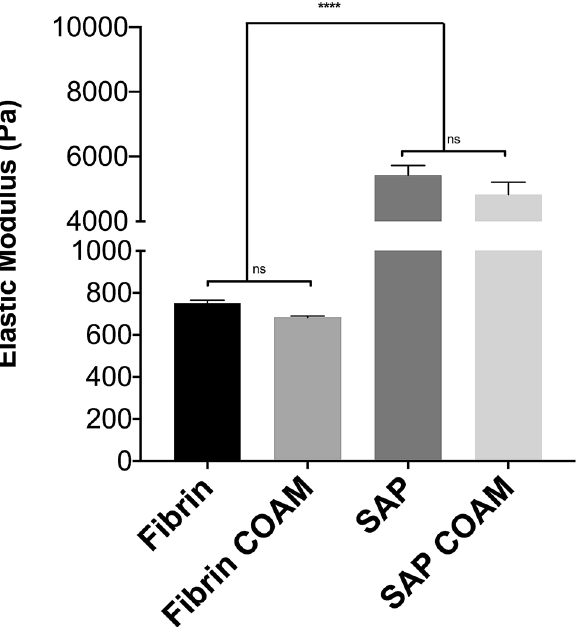
Figure 3. Hydrogels stiffness: The elastic modulus for fibrin hydrogels at 3.5 mg/ml fibrinogen concentration and SAP hydrogels at 3.5 mg/ml RADA-16 concentration. Results are presented as mean ± SEM; ns refers to not significant, *significant